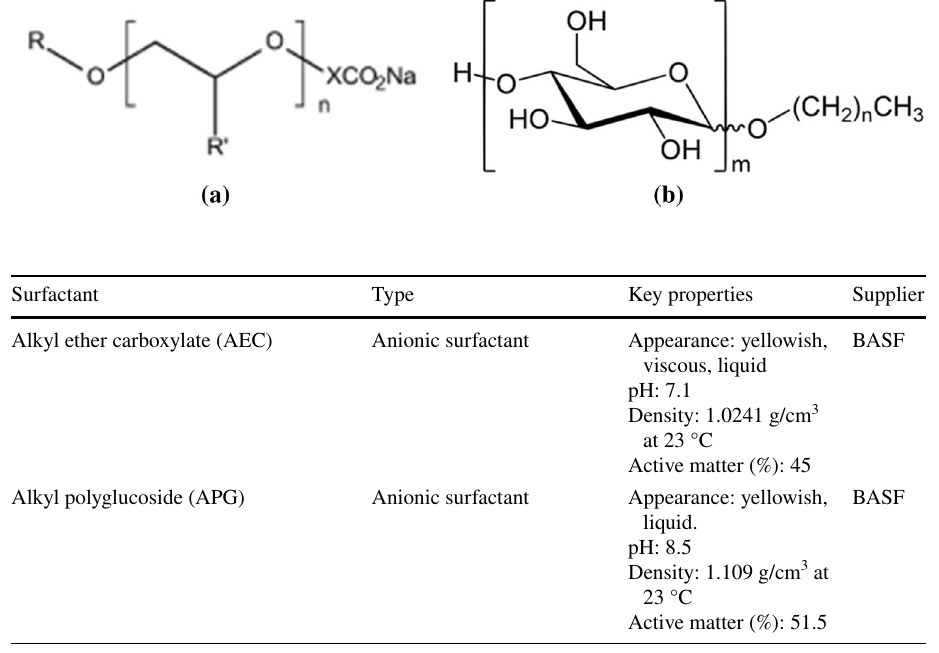
Fig. 2 General chemical struc-